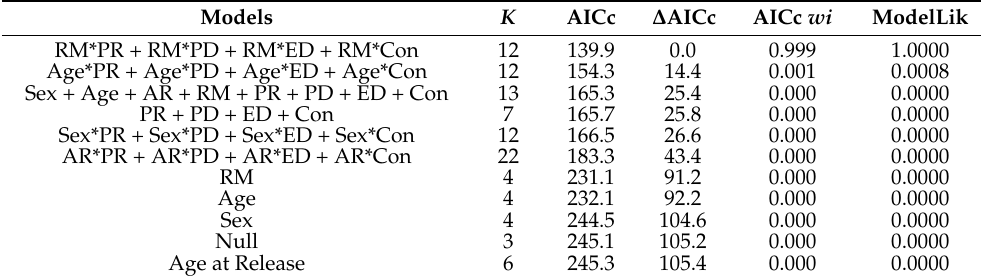
Table 1. Models fitted to explain the home range size of captive-reared and wild-rehabilitated Harpy Eagles ( Harpia harpyja ) released in Central American landscapes. All models contain a random effect for the individual. K = number of model parameters, ∆ AICc = difference between AICc values from the competitive and top model, AICc wi = model weight, ModelLik = relative likelihood of the model. RM = Release method, AR = Age at Release, PR = Patch richness, PD = Patch density, ED = Edge density, Con =